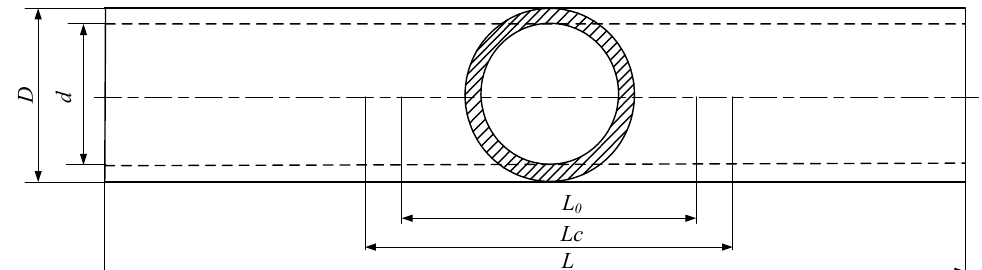
Figure 2. Schematic diagram of tensile experiment section sample.